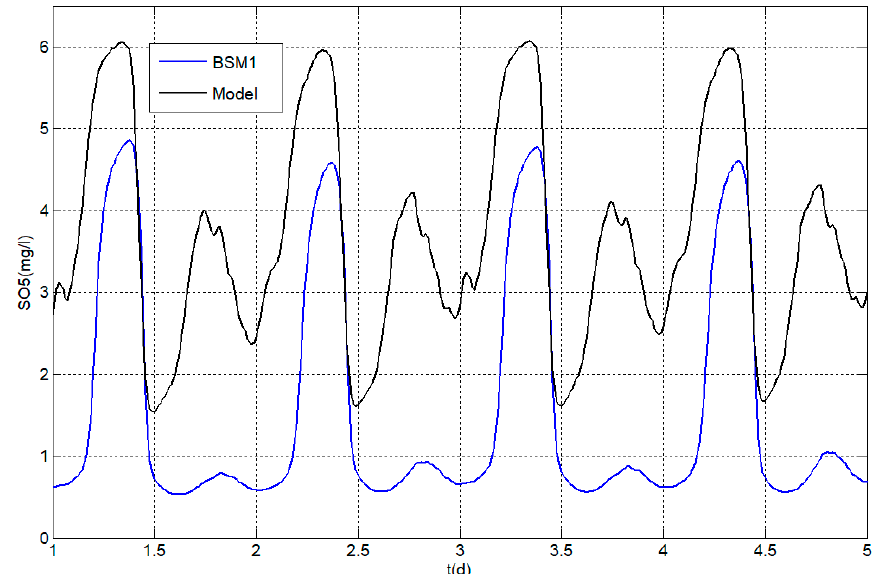
Figure A2. Comparison of the reduced model and BSM1 evolution of the oxygen concentration in the fifth reactor (aerobic) obtained in the open loop operation, using the manipulated variables values that produce the nominal set points.